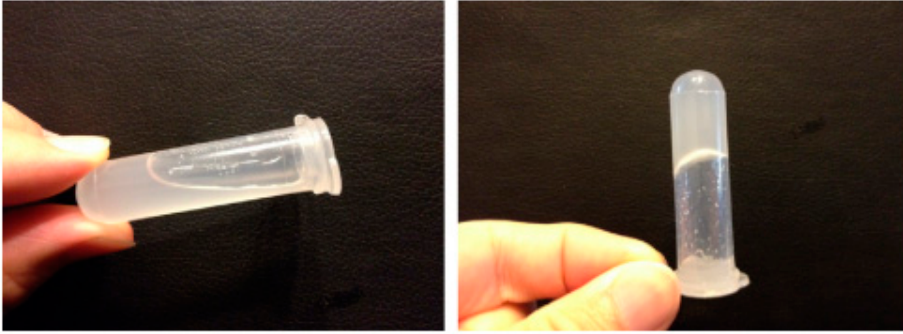
Figure 10. In vitro hydrogel formation with in situ gels (0.6%) and artificial tears [117].